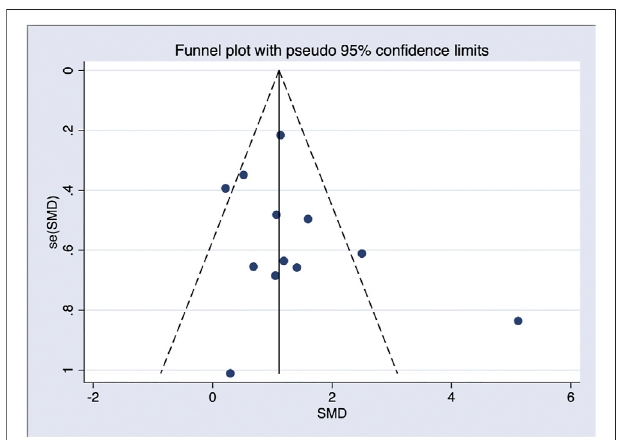
FIGURE 6 | PRP ef fi cacy compared to placebo.